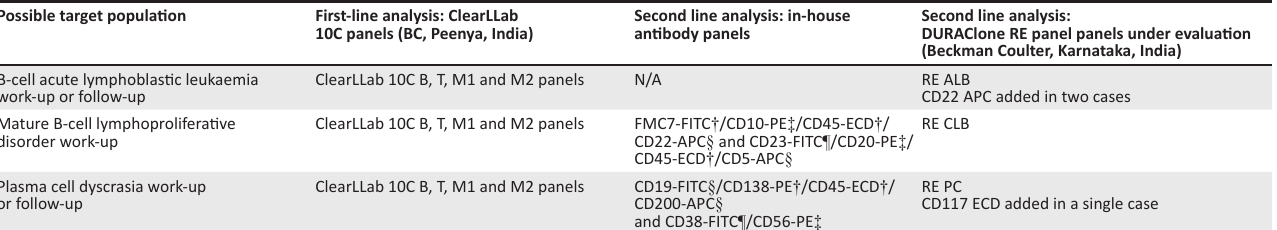
TABLE 1: Possible reagent selection for method comparison according to suspected target population undertaken from April 2020 to August 2020 at an academic pathology service in Johannesburg, South Africa. Possible target population First-line analysis: ClearLLab Second line analysis: in-house Second line analysis: 10C panels (BC, Peenya, India) antibody panels DURAClone RE panel panels under evaluation (Beckman Coulter, Karnataka,